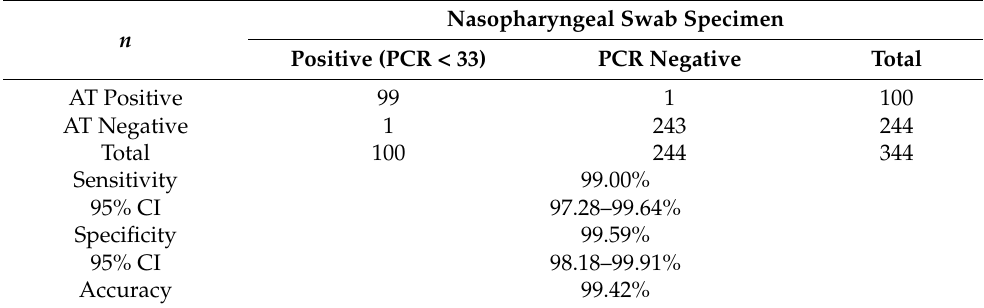
Table 2. Test results and analysis of nasopharyngeal swab specimens with Ct values of PCR positivity less than 33.